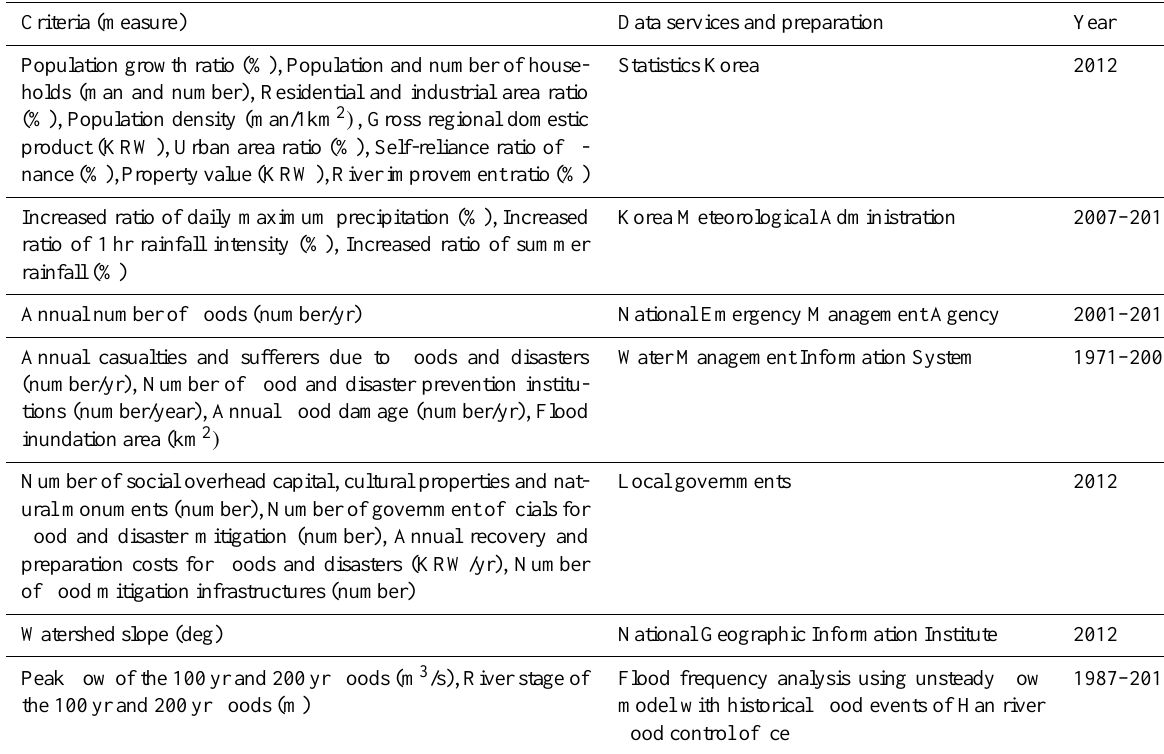
Table 5. Sources of the input data.